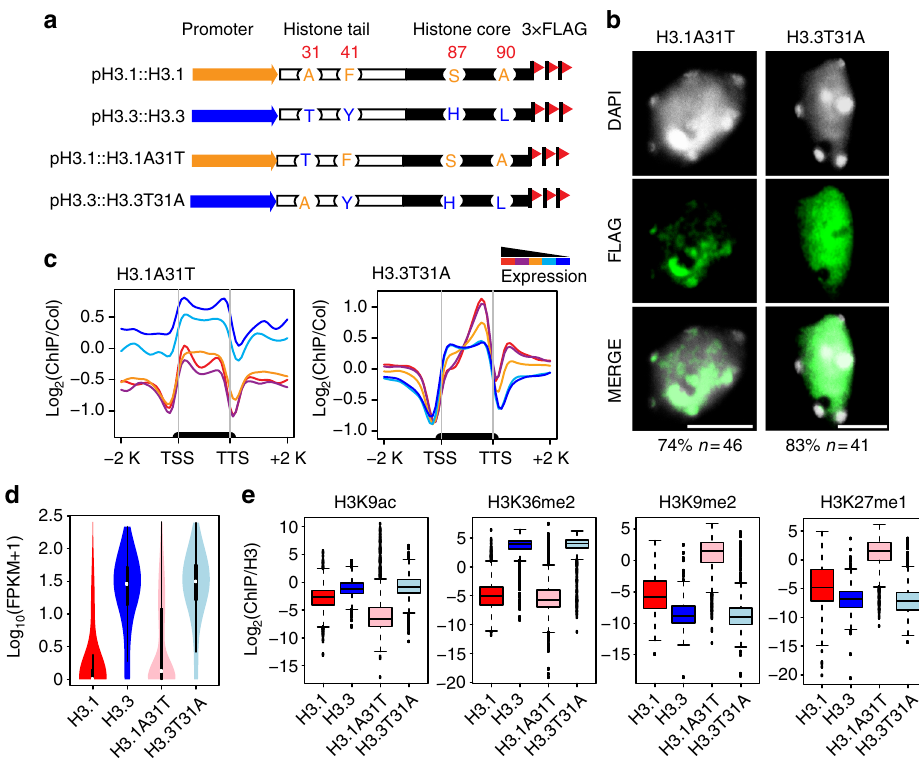
Fig. 4 Ala/Thr31 is not decisive for genome-wide H3 distribution pattern. a Schematic diagram of H3.1, H3.3, H3.1A41T, and H3.3T31A FLAG-tagged constructs. b Localization of H3.1A31T and H3.3T31A protein in nuclei (bar = 5 μ m). The n represents the total number of examined nuclei. The percentage describes the ratio of the nuclei showing the H3 distribution pattern out of total examined nuclei. DAPI indicates the DAPI staining of the nucleus. c Metagene plots of H3.1A31T and H3.3T31A ChIP-seq reads over fi ve groups of genes divided based on their expression levels. The black bar in the x -axis represents genes. TSS transcription start sites, TTS transcription terminal sites; − 2 K and +2 K represent 2 kb upstream of TSS and 2 kb downstream of TTS, respectively. The y -axis represents the log 2 value of H3.1A31T and H3.3T31A ChIP-seq reads normalized to those of Col-0. d Violin plots of the expression levels of genes associated with H3.1, H3.3, H3.1A31T, and H3.3T31A ChIP-seq peaks. The y -axis represents the log 10 value of FPKM +1. FPKM fragments per kilobase of transcript per million mapped reads. RNA-seq data were from 3-week-old seedlings. e Boxplots of histone modi fi cation levels in ChIP-seq peaks of H3.1, H3.3, H3.1A31T, and H3.3T31A. The y -axis represents the ChIP-seq reads normalized with those of H3. Histone modi fi cation